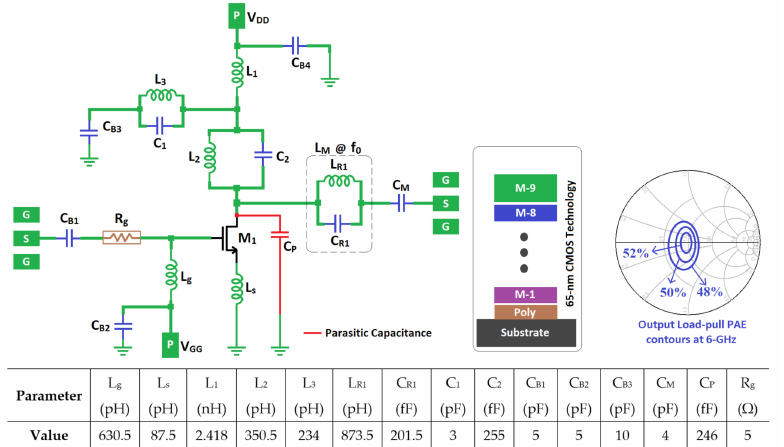
Figure 1. Circuit diagram of the proposed “single-transistor” Class-F − 1 PA in TSMC 65 nm CMOS and its load-pull PAE contours at 6 GHz. The figure also shows the BEOL stacked metal layers of the technology with color-coded scheme (reflecting the corresponding components in the schematic), as well as the values of the component